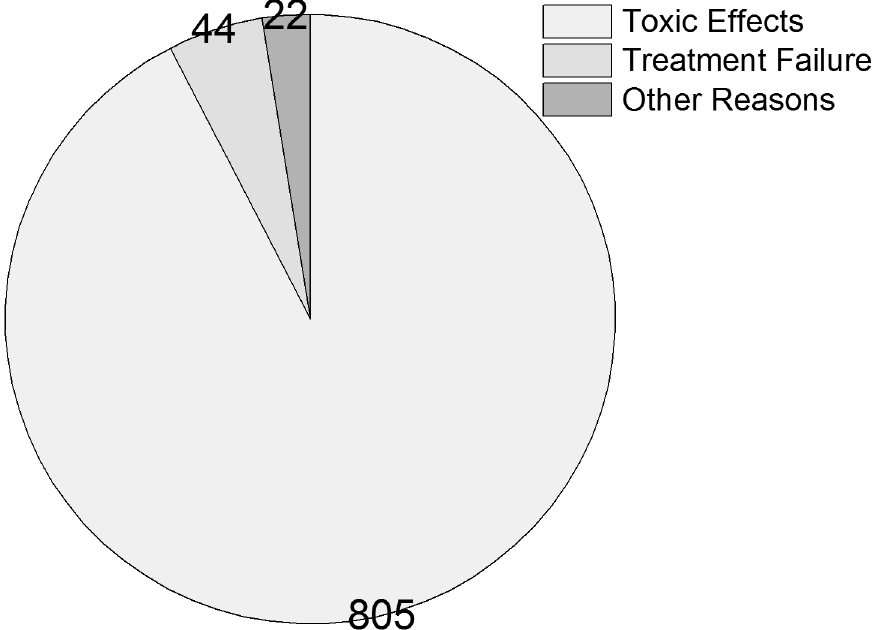
Fig 2. The reasons for the first regimen